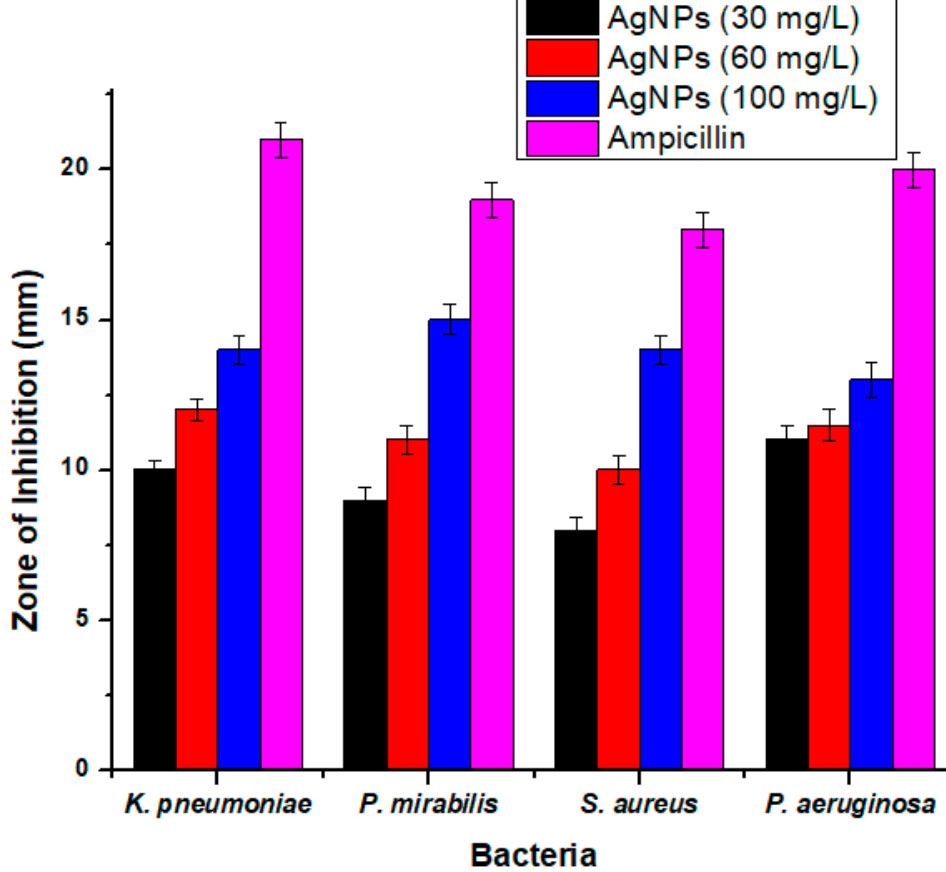
Figure 7. Antibacterial activity of AgNPS synthesized from Elaeagnus umbellata fruit extract.